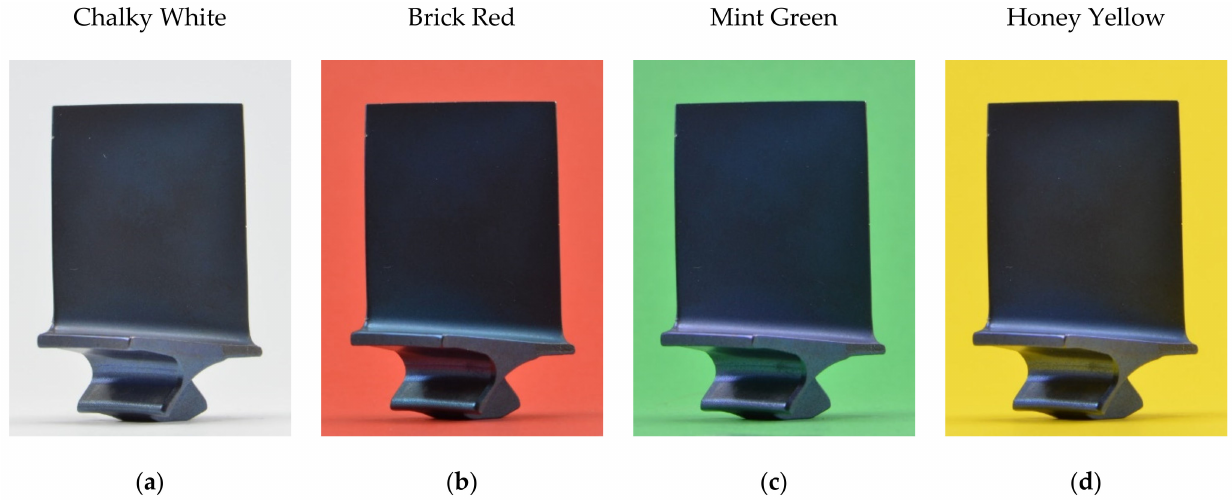
Figure 7. Blade with different coloured backgrounds: ( a ) chalky white (RGB: 229, 230, 232), ( b ) brick red (RGB: 230, 99, 79), ( c ) mint green (RGB: 111, 194, 124), and ( d ) honey yellow (RGB: 241, 212, 59). Hypothesis 5 (H5). The background colour affects the inspection